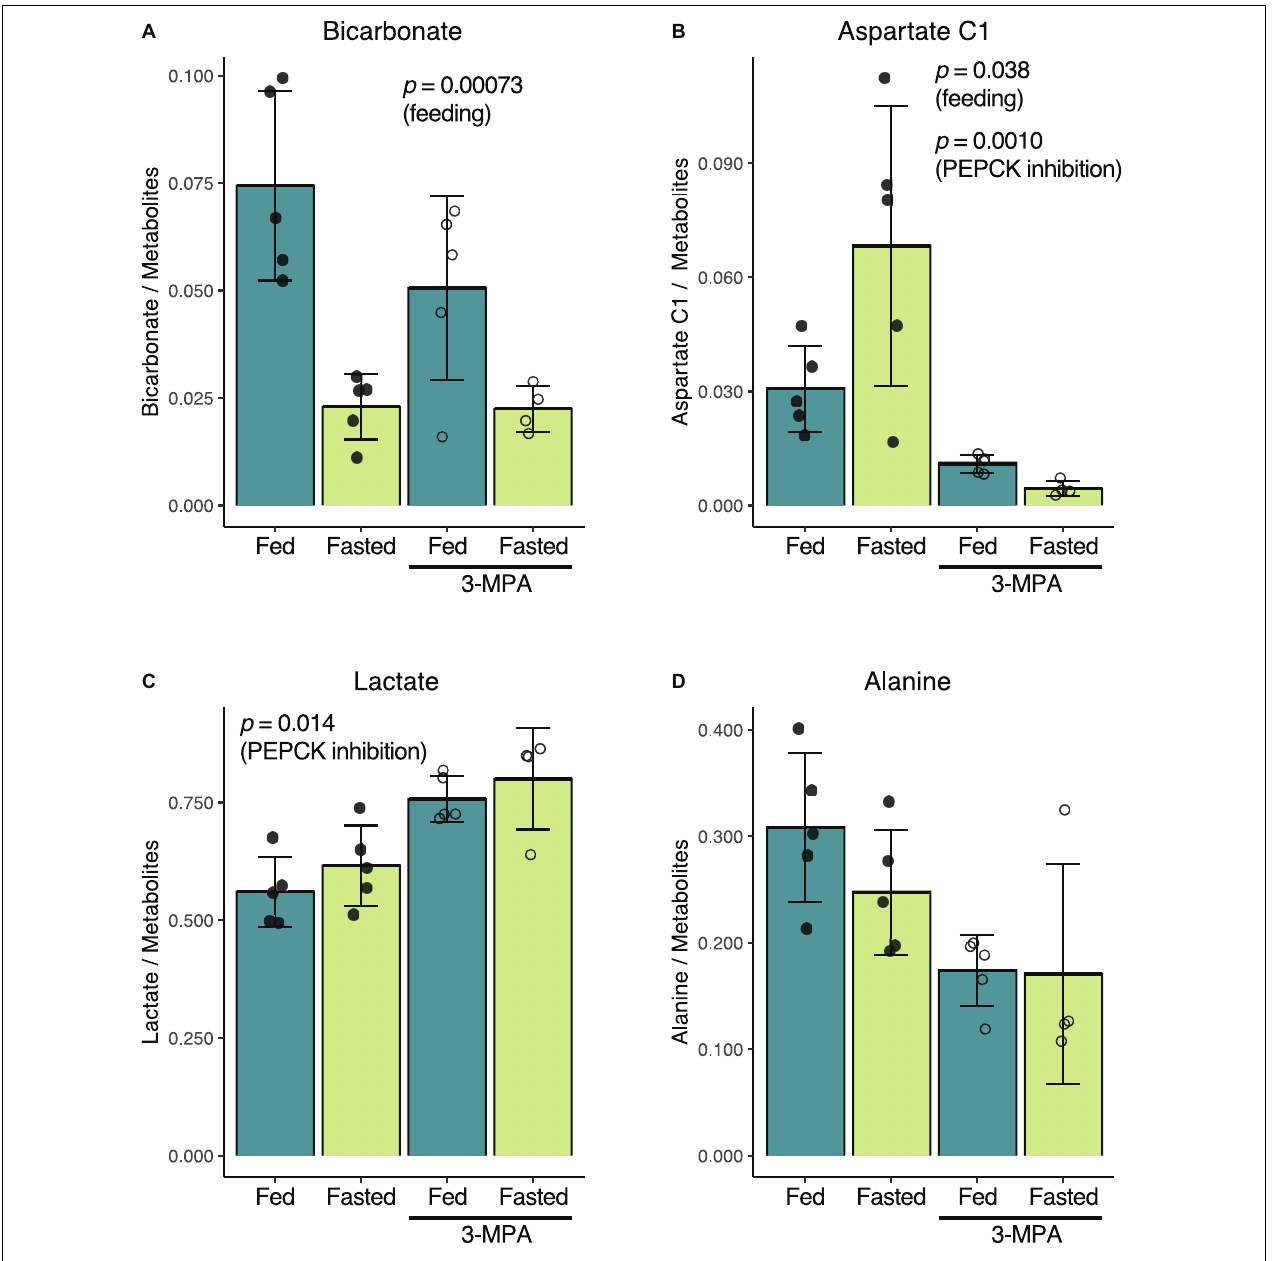
FIGURE 3 | Effect of fasting and PEPCK inhibition by 3-MPA on renal conversion of [1- 13 C]pyruvate to bicarbonate (A) , aspartate (B) , lactate (C) , and alanine (D) . Metabolite-to-total metabolite signal ratios are calculated from the fitted spectral amplitudes of summed spectra from each infusion series. Filled dots represent values from untreated rats, while open circles are from 3-MPA-treated rats. The indicated p -values were calculated by two-way ANOVA, and they note the factor responsible for the significant difference.